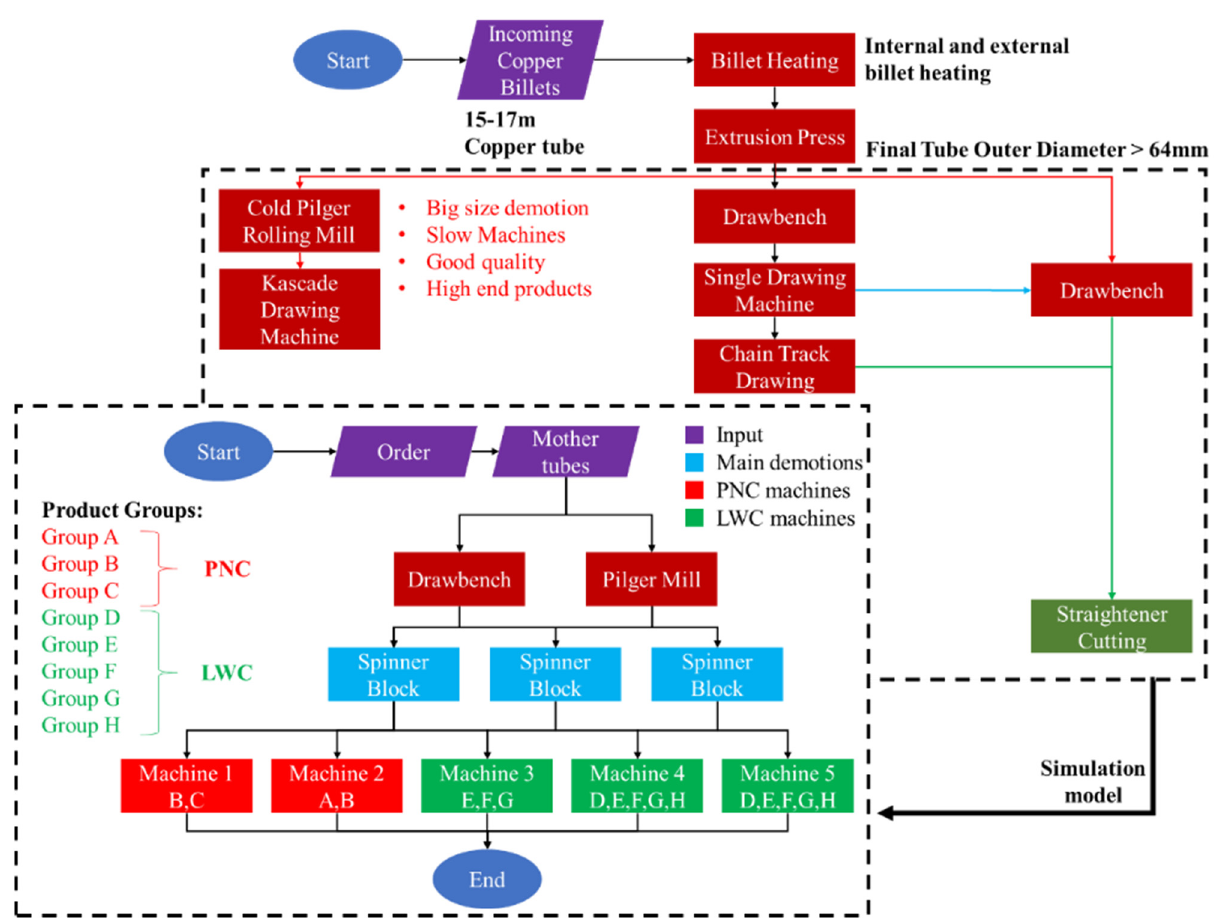
Figure 1. Line part simulation of the production .